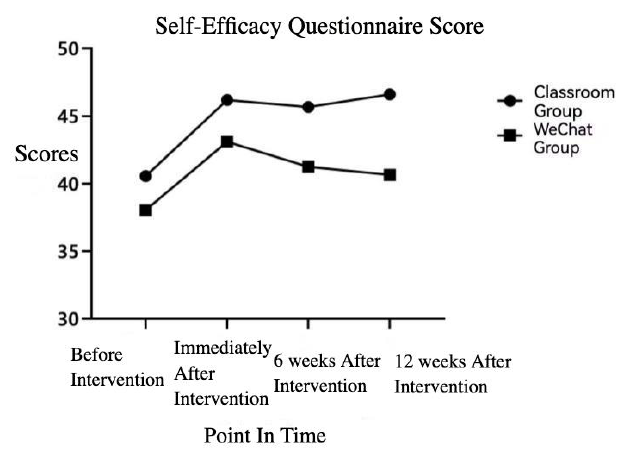
Figure 2. Self-efficacy questionnaire score trend.